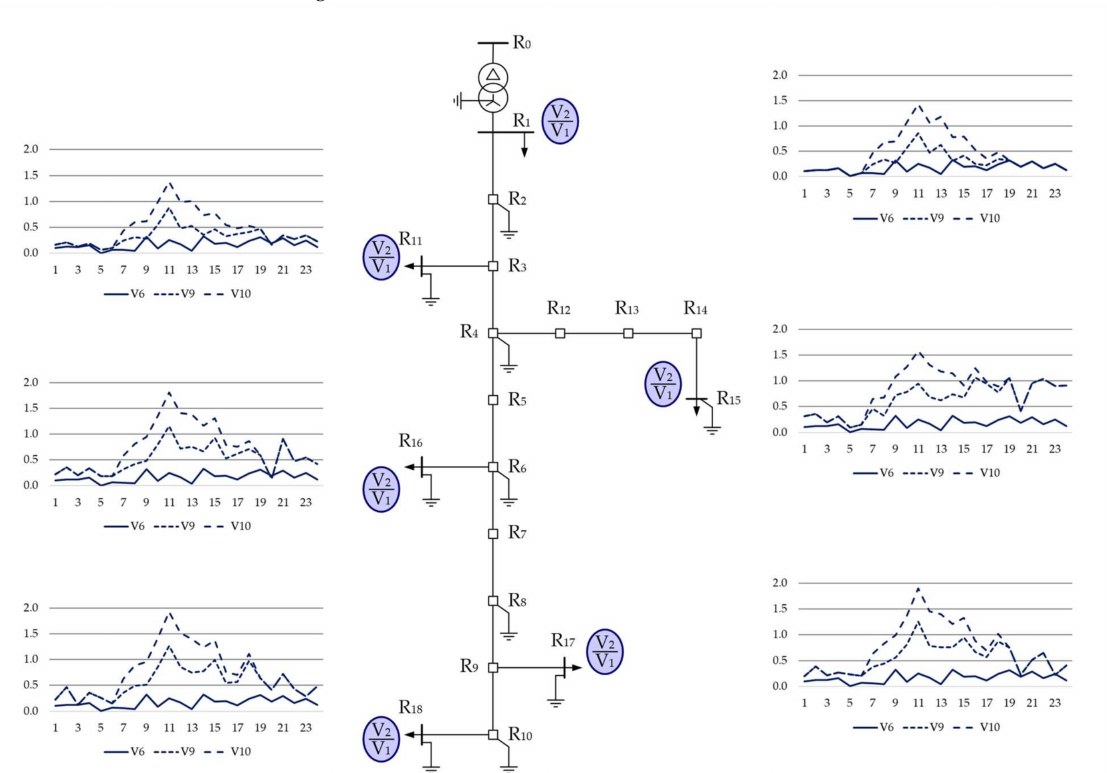
Figure A18. Daily simulation results for variants V6, V9, and V10: negative sequence component of bus voltage